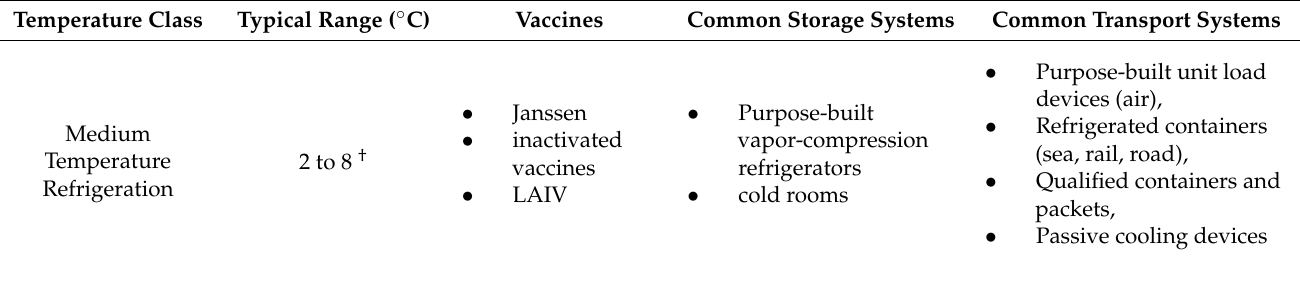
Table 5. Vaccine transport and storage systems and